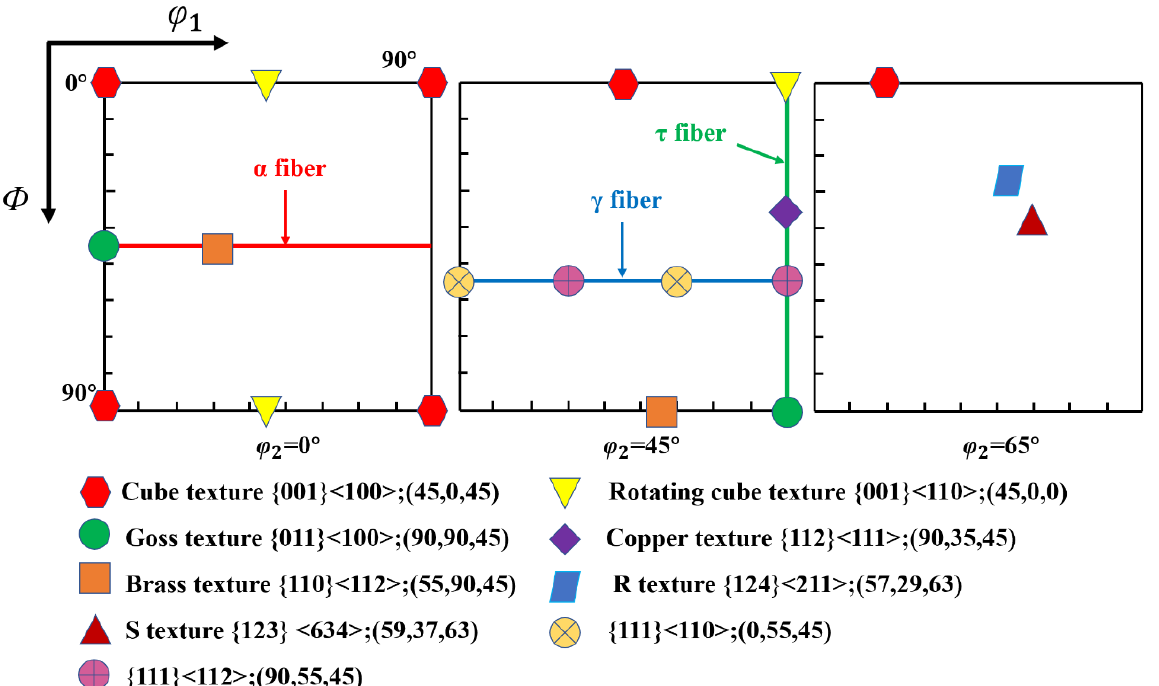
Figure 12. The distribution of ideal texture components of the nickel-based superalloys; orientation distribution function (ODF) maps at φ 2 = 0°, 45°, and 65°.